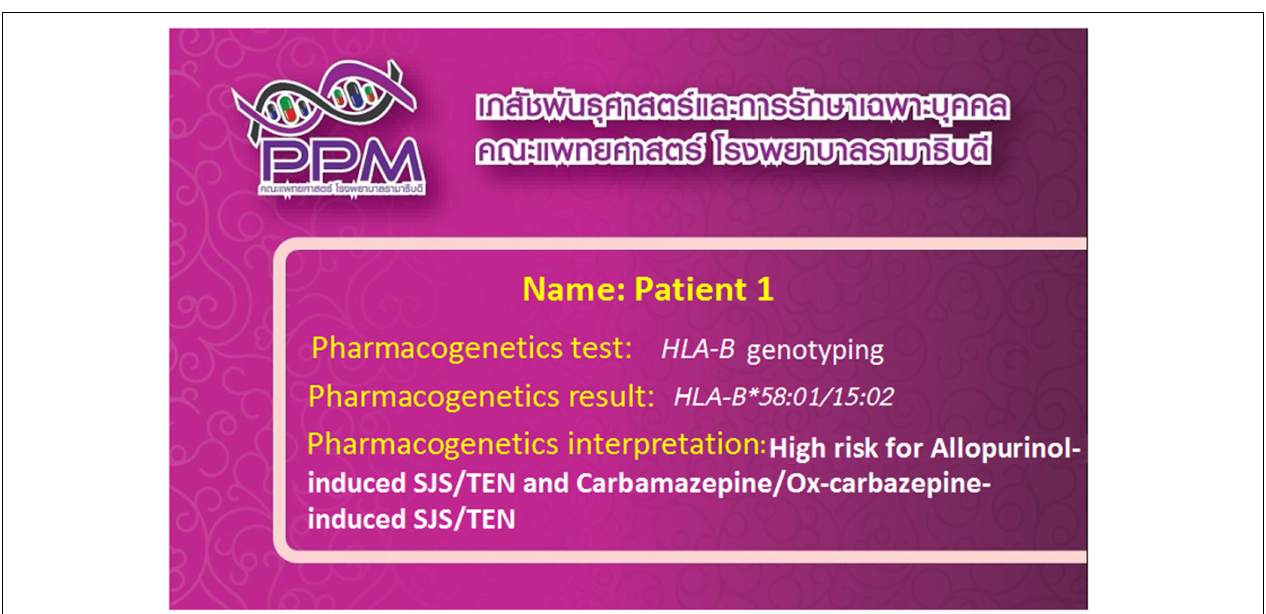
FIGURE 1 | “Pharmacogenomics cards” have been successfully implemented in clinical practice in Thailand. The patients are tested for the HLA-B alleles which are associated with the ADRs related with the use of concerned drugs.